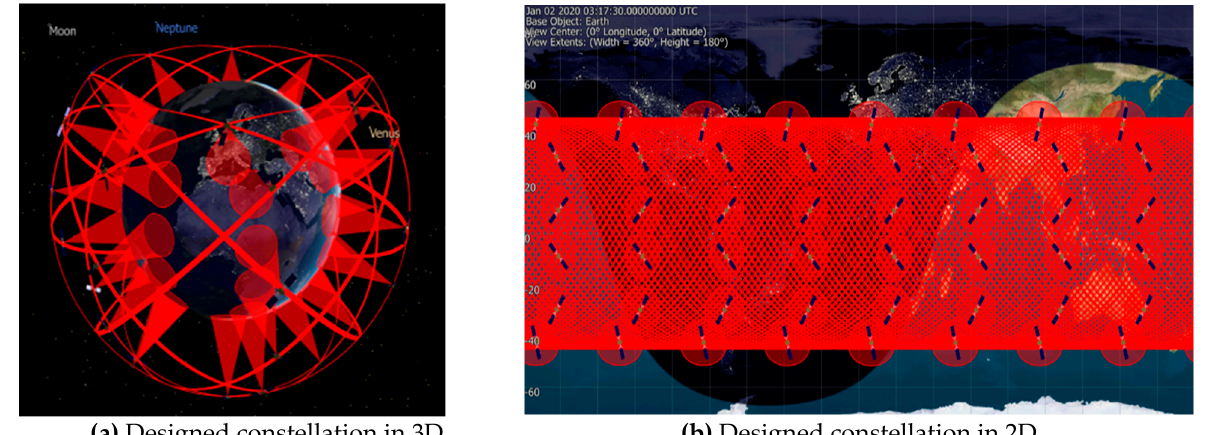
Figure 6. Constellation simulation (48 satellites)—3D and 2D .